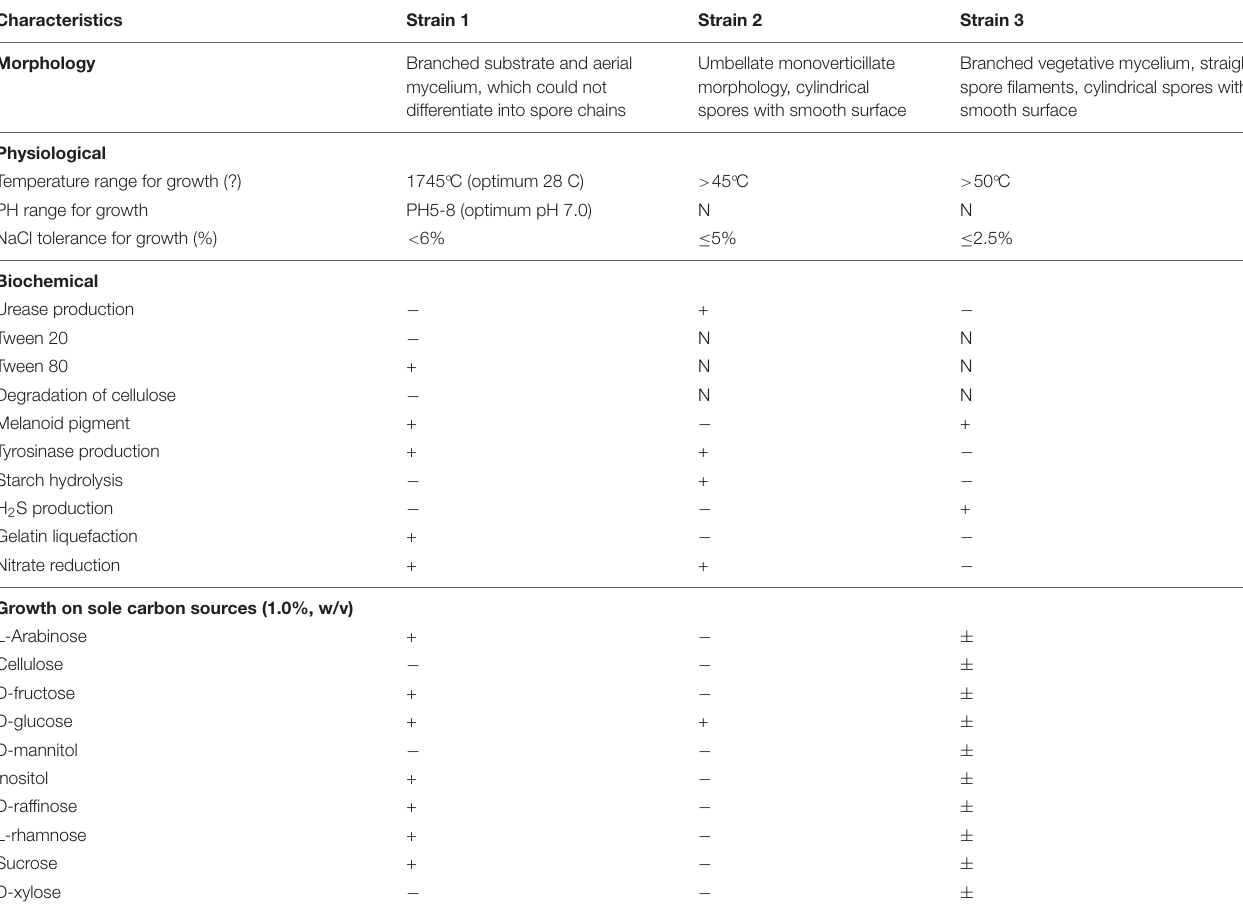
TABLE 2 | Morphological, physiological and biochemical characteristics of strain SCA2-4 T and two standard strains.